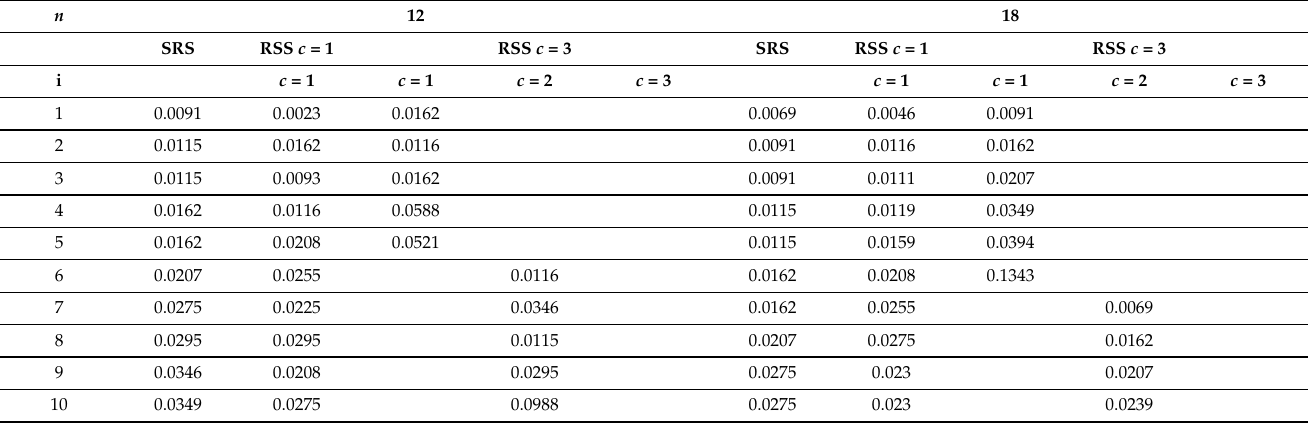
Table 13. SRS and RSS for the COVID-19